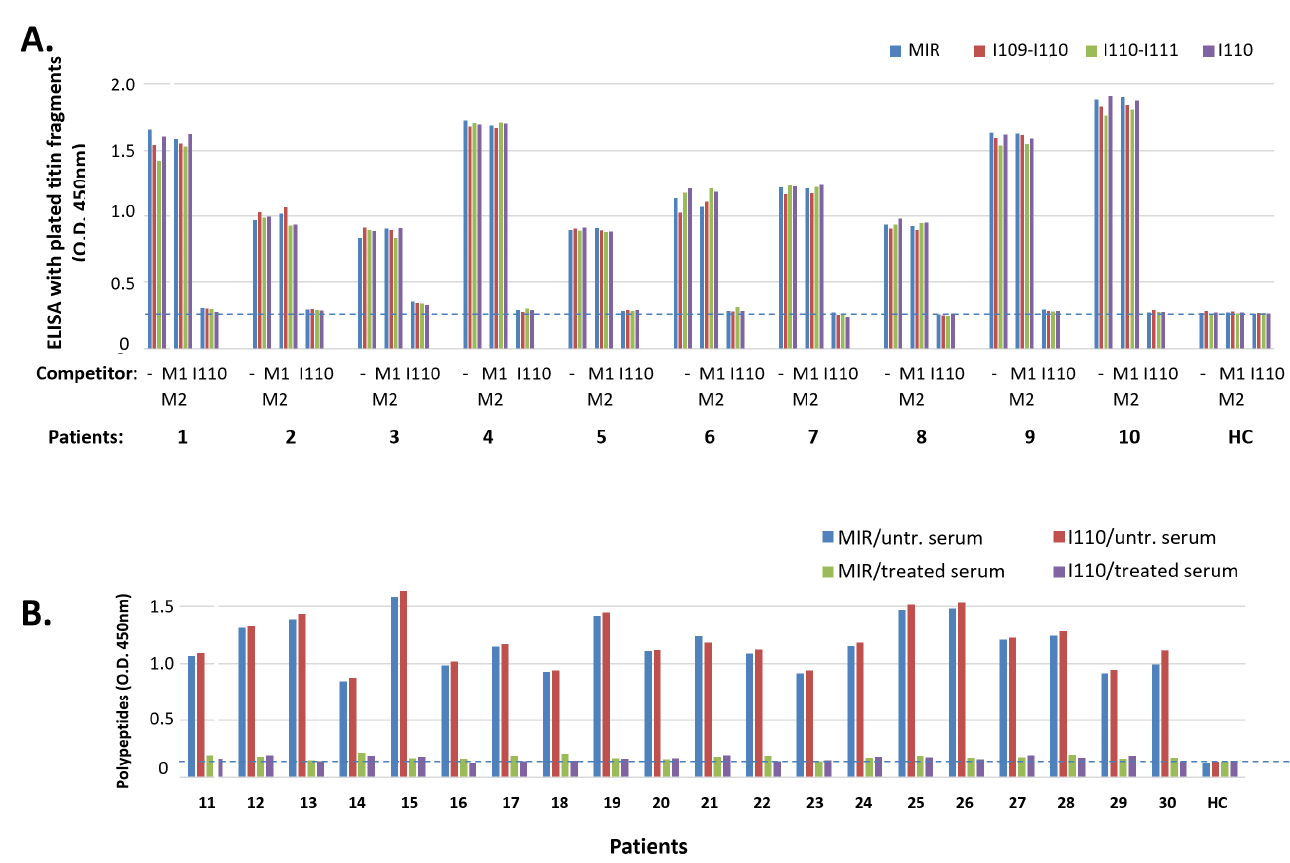
Figure 3. Efficiency of the I110 domain to block sera from binding to the MIR and MIR fragments. ( A ) Binding of the 10 MG sera of Figure 2 to the four MIR fragments and inhibition of binding by the soluble M1-M2 and I110 fragments. Each serum, before incubation with the immobilized titin